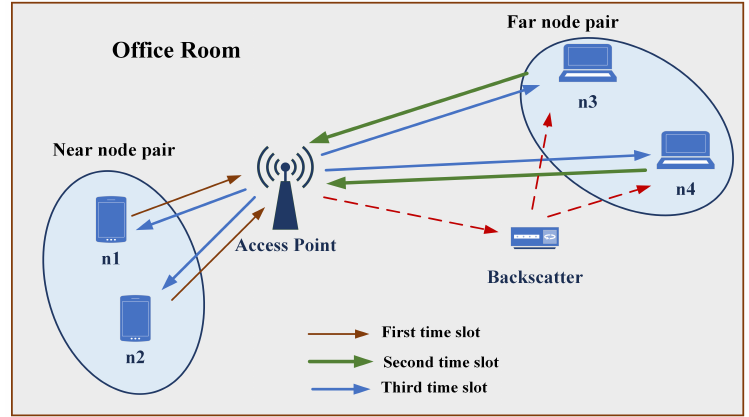
Figure 1. A two pairs NOMA-PLNC-based wireless network with ambient backscattering.